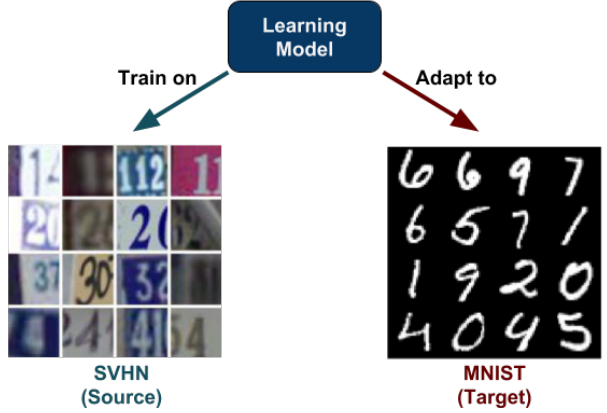
Figure 1. Both SVHN and MNIST datasets contain images of digits; however, there are many differences between them. SVHN images are real-world RGB images of digits (in different orientations) taken from street house numbers, whereas MNIST is a handwritten-digit dataset, where all images are in greyscale and have digits in a fixed orientation. The domain gap results from such differences in style, brightness, and contrast, among others. Domain adaptation aims at closing the above-mentioned gap between different datasets, such that an image classification model trained on SVHN would perform well on MNIST images,